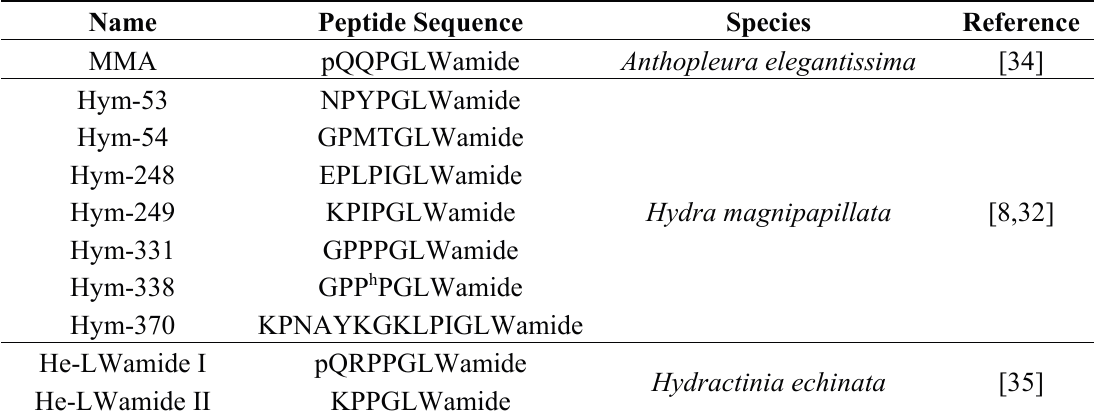
Table 2. GLWamide-family peptides in